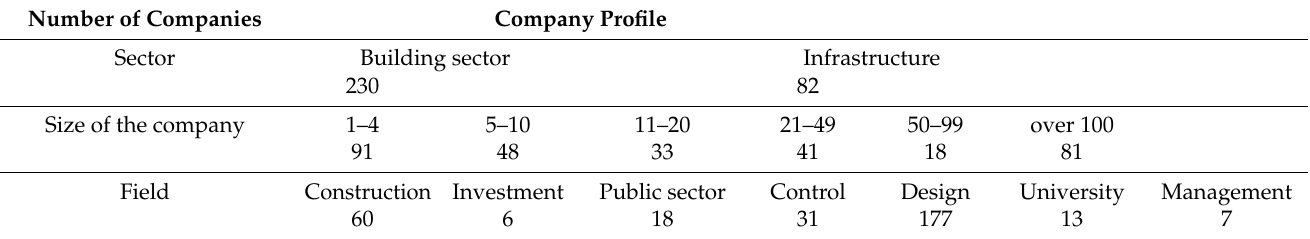
Table 3. Statistics about the profiles of the companies to which the respondents belong.